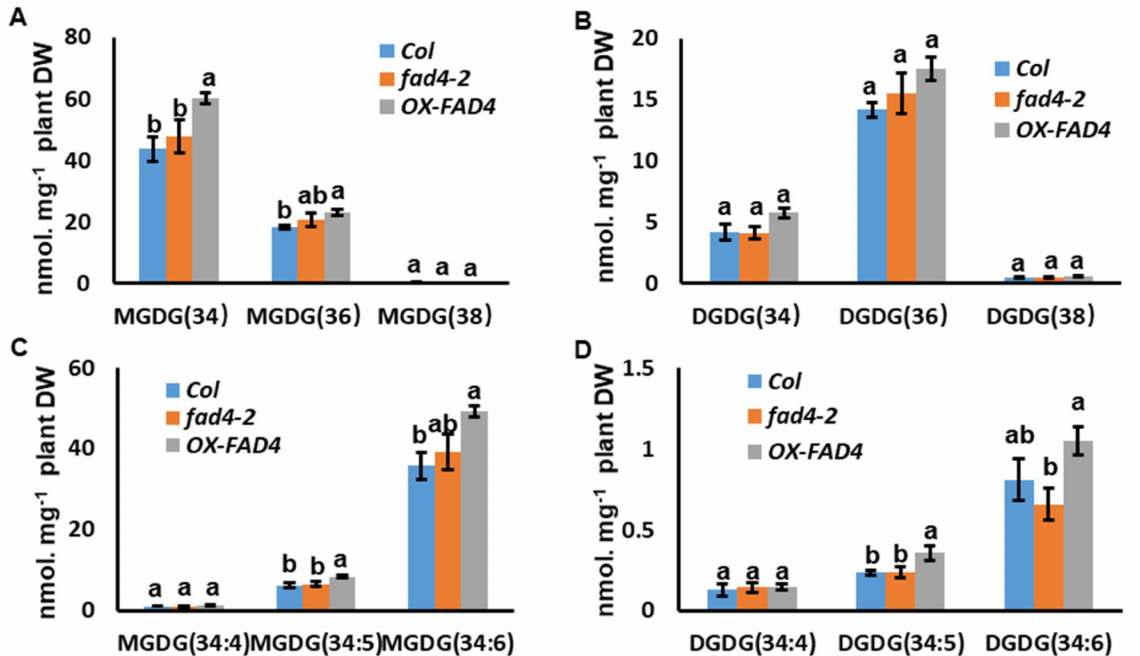
Figure 8. The contents of MGDG and DGDG molecular species from WT, fad42 , and OXFAD4_2 plants. ( A ) MGDG molecular species contents from WT, fad42 , and OXFAD4_2 . ( B ) MGDG (34) molecular species contents from WT, fad42 , and OXFAD4_2 . ( C ) DGDG molecular species contents from WT, fad42 , and OXFAD4_2 . ( D ) DGDG (34) molecular species contents from WT, fad42 , and OXFAD4_2